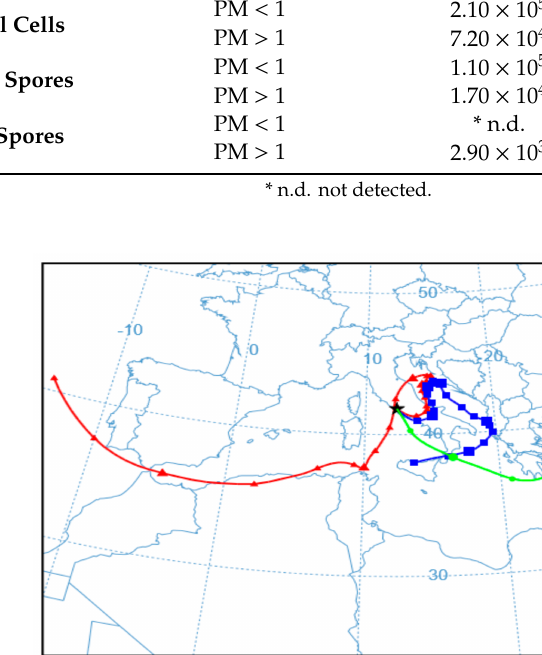
Figure 5. Simulation, according to the HYSPLIT model, of the wind trajectory coming from the desert areas of North Africa (16 April 2018 H